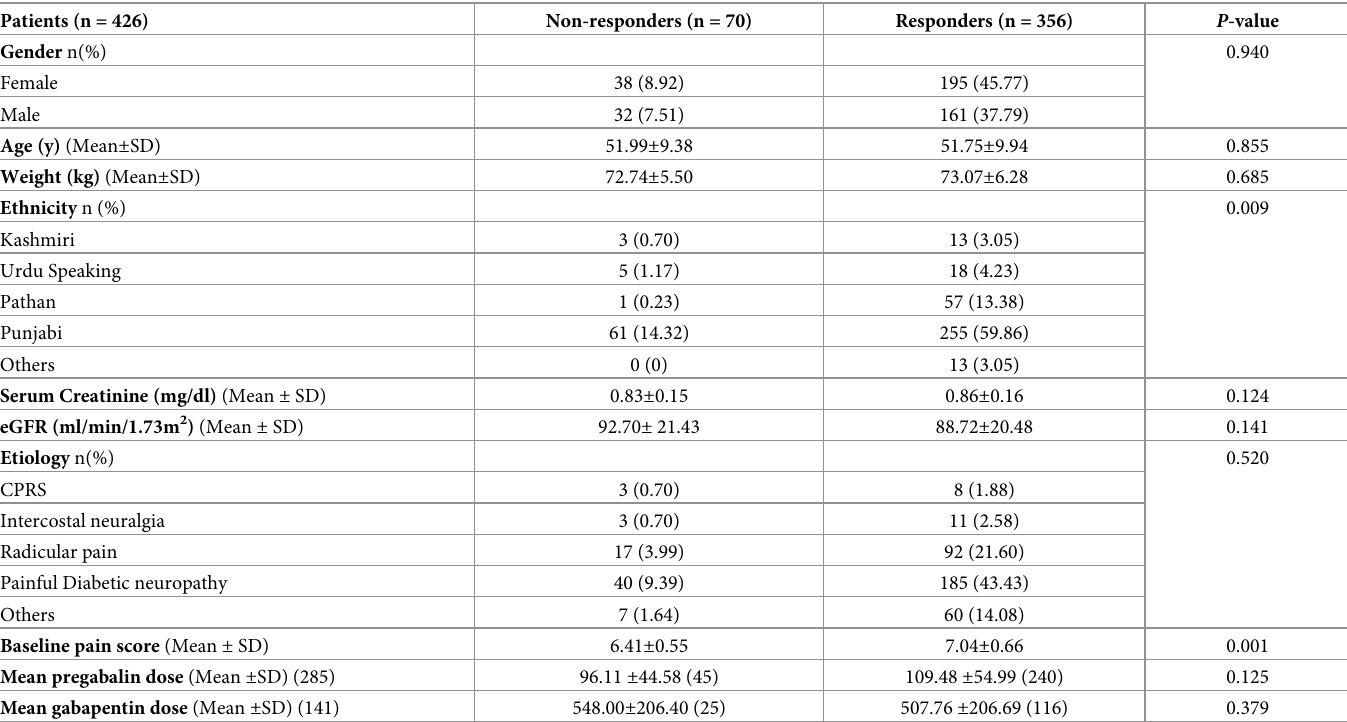
Table 1. Demographic and baseline characteristics.